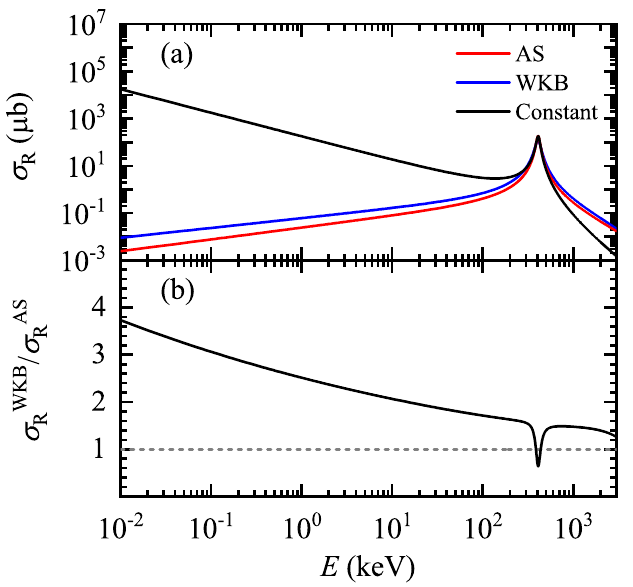
Figure 2. (a) Resonant cross section of 411 keV resonance of 16 O( n ,γ ) 17 O, with a constant decay width = 40 keV (black line), and two energy-dependent Γ Γ n the WKB approximation (blue line). (b) ratio of σ WKB